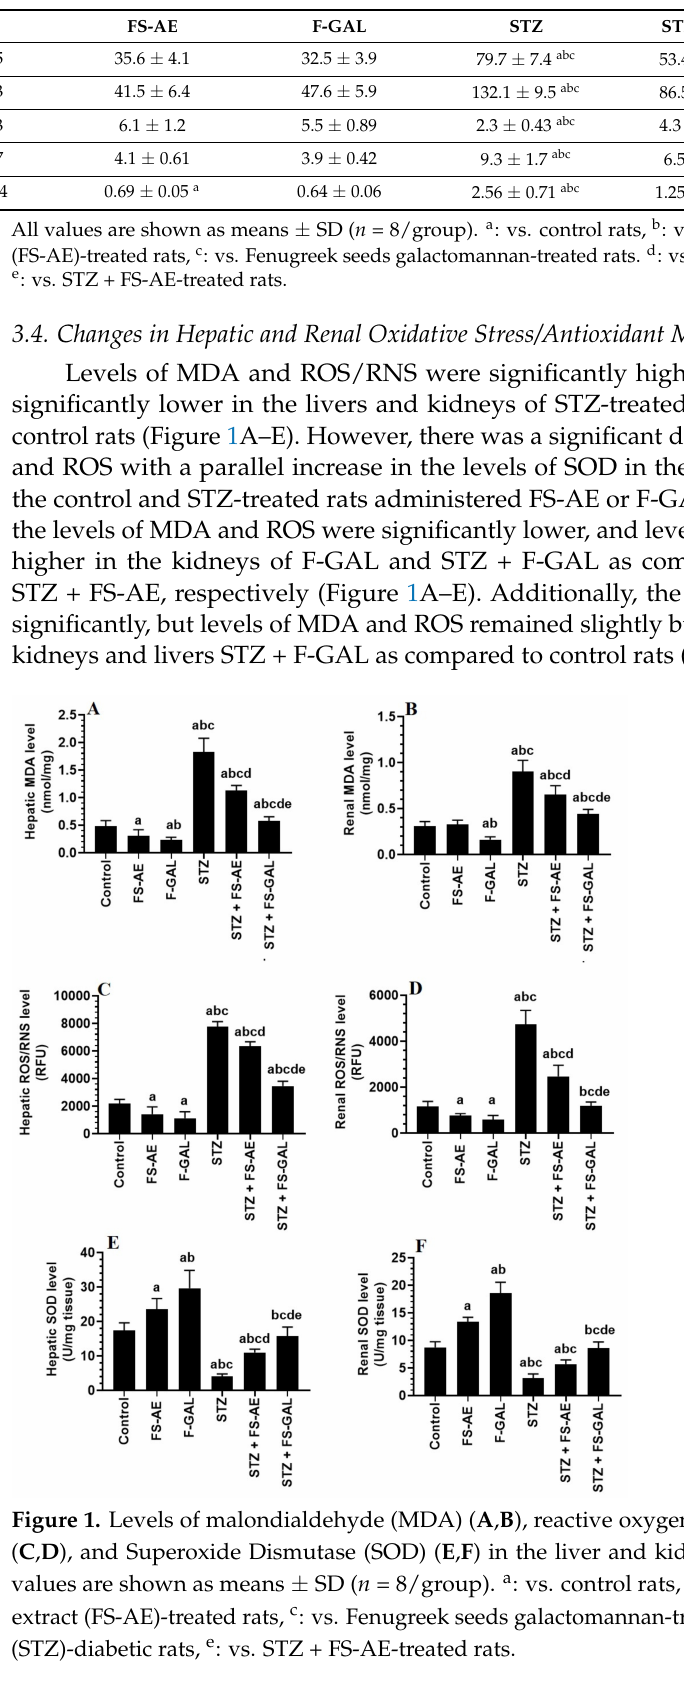
Table 4. Levels of kidney and liver function markers in all groups of rats.